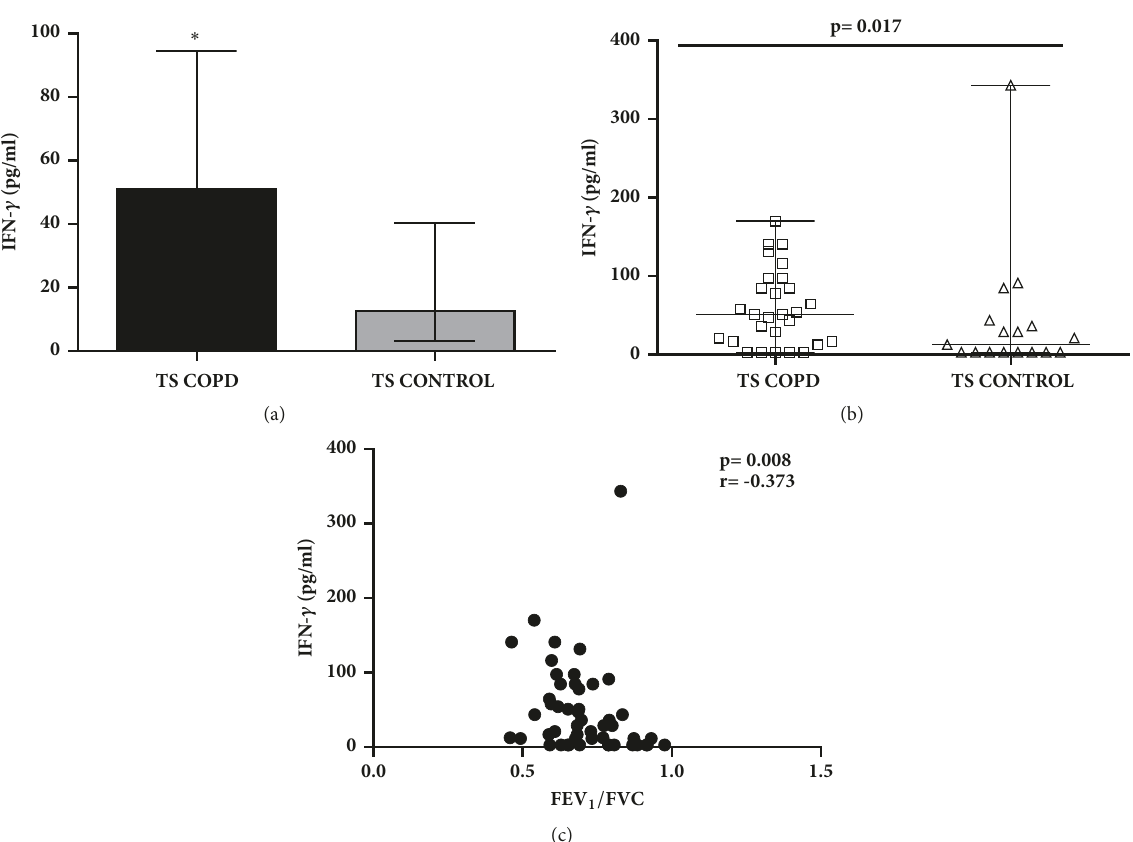
Figure 2: Serum concentrations of interferon gamma (IFN- 𝛾 ) and corresponding correlation with lung function parameters among long-term smokers with or without chronic obstructive pulmonary disease (COPD) . (a, b) IFN- 𝛾 concentrations were increased in TS COPD group compared to TS CONTROL group (p=0.017); inverse correlation of IFN- 𝛾 concentrations to (c) FEV 1 /FVC was detected in the study cohort. ∗ p < 0.05 was considered as statistically significant. Data is presented as median (25th-75th percentile); TS COPD: n=30 and TS CONTROL: n=20; ∗ p < 0.05 was considered as statistically significant. COPD : chronic obstructive pulmonary disease; FEV 1 /FVC : forced expiratory volume 1 second postbronchodilator challenge/forced vital capacity; FEV 1 : forced expiratory volume 1 second (pre) prebronchodilator challenge; FEV 1 : FEV 1 postbronchodilator challenge; TS COPD : tobacco smokers with COPD; TS CONTROL : (post) tobacco smokers without